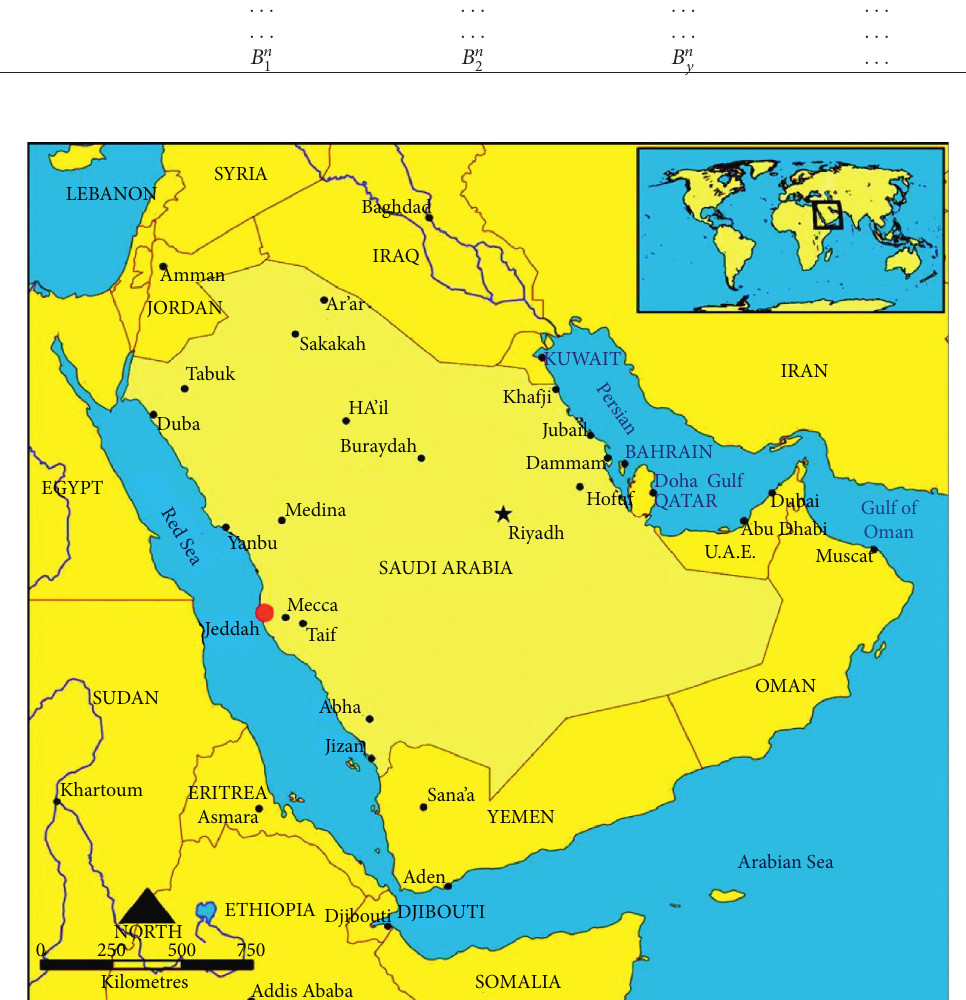
Figure 1: Location of Jeddah city in Saudi Arabia.